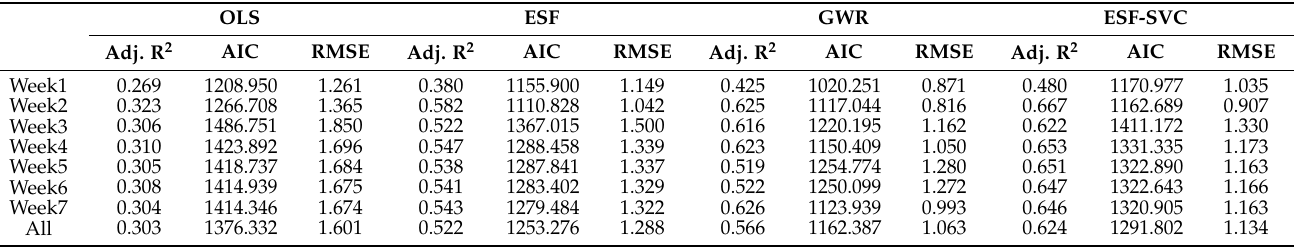
Table 10. Model performance comparison in mainland